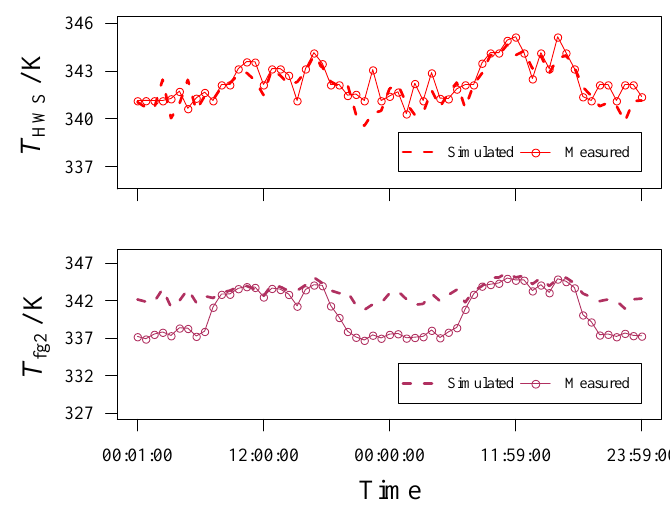
Figure 10. ( Top ) Hot water supply temperature at the outlet of the MGTHX’s hydraulic loop over time; ( Bottom ) Flue gas temperature at the outlet of the MGTHX over time. The simulated data was obtained by means of the input signals given in Figure 8. The maximum absolute discrepancy for T HWS and T fg2 was about 2.7K and 5.7K.